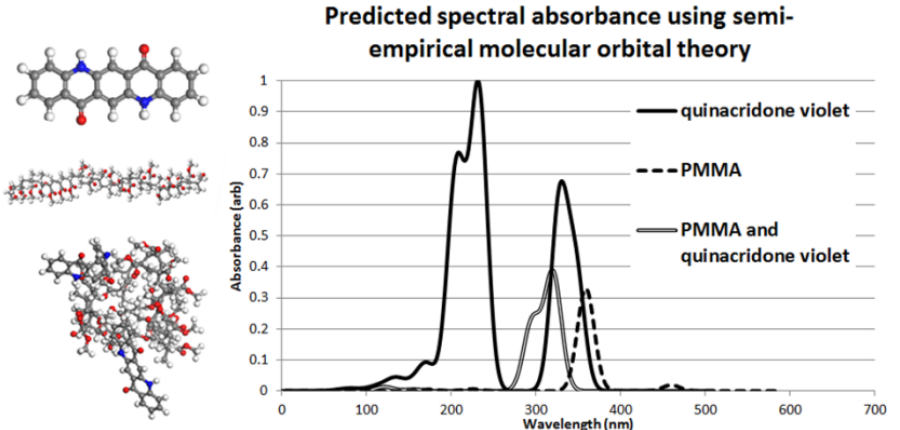
Figure 8. Semi-empirical molecular orbital theory predicts the optimized geometry of various components in a colored system, as well as the spectral absorbance spectra.